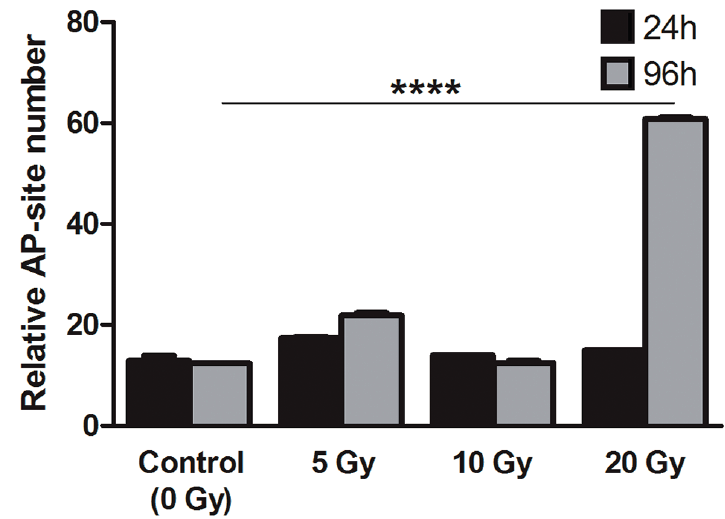
Figure 6. AP-site level in human thyrocytes cultured with 131 I. The graph presents AP-site level (AP-sites/100,000 bp ± SD) in DNA measured in samples obtained from cultured thyrocytes directly after 24 h of 131 I exposure (5, 10, and 20 Gy) or after additional 72 h of culture without 131 I ( **** p <